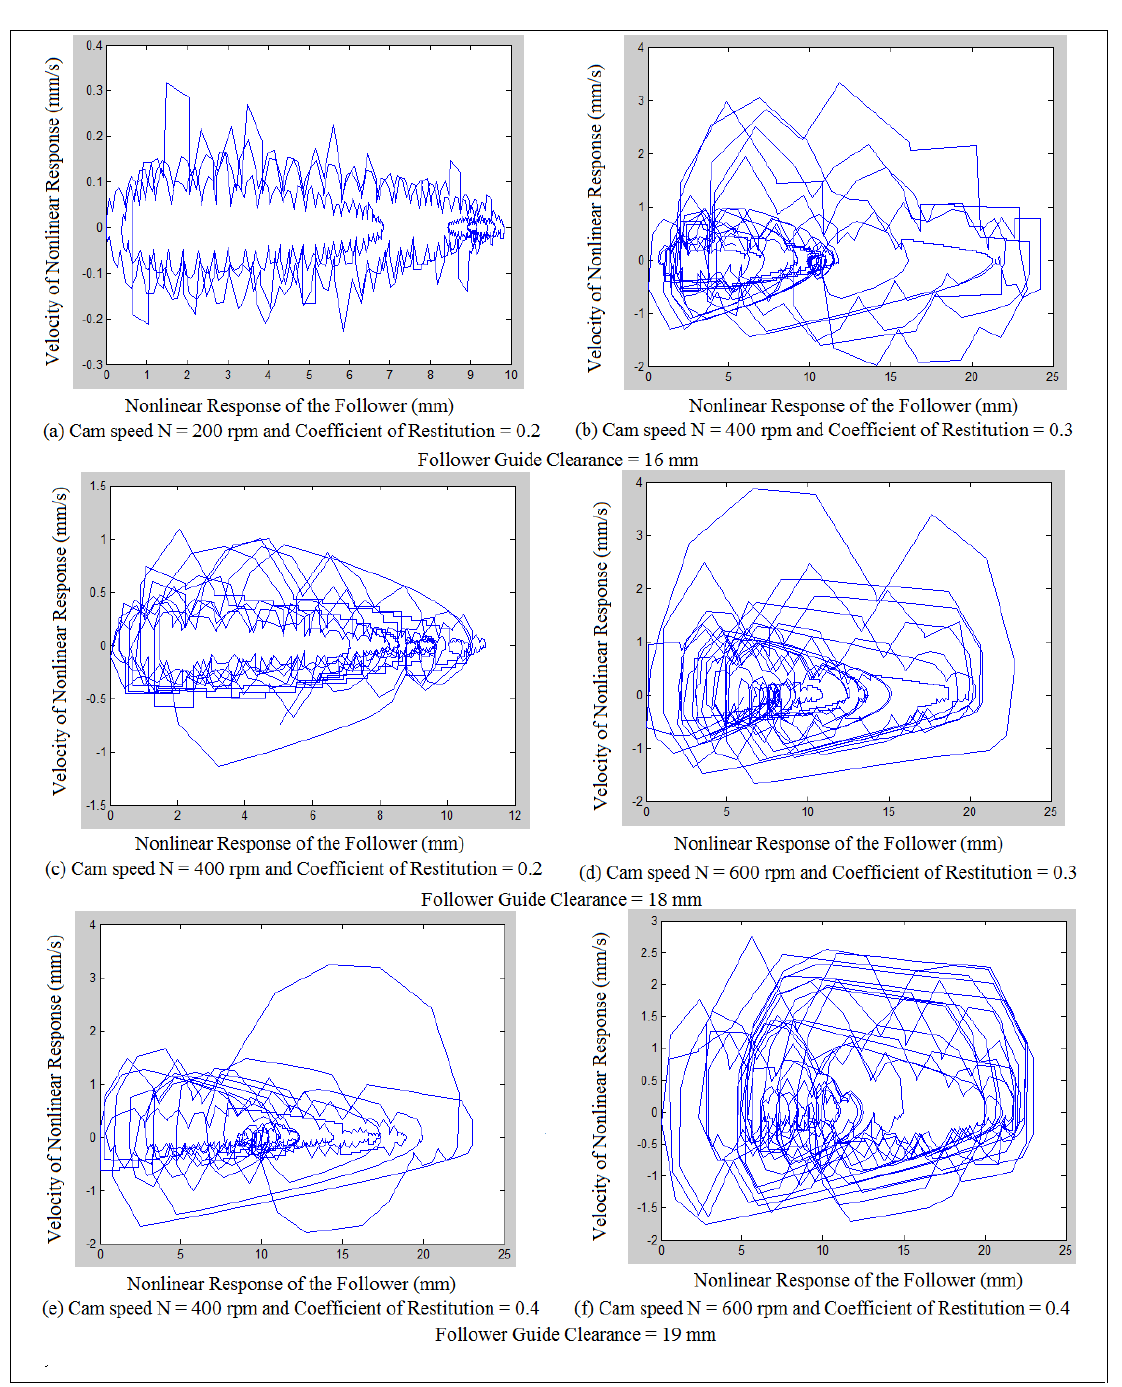
Figure 8. Phase-plane mapping of nonlinear response of the follower when the follower offsets to the right at (O = 10 mm).